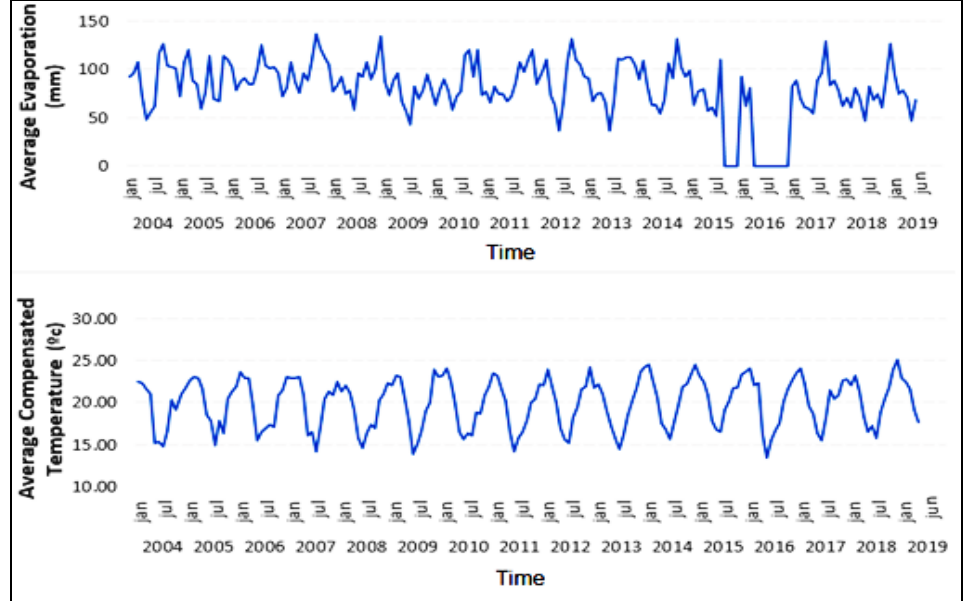
Table 16. Non-parametric tests for trend and seasonality analysis.